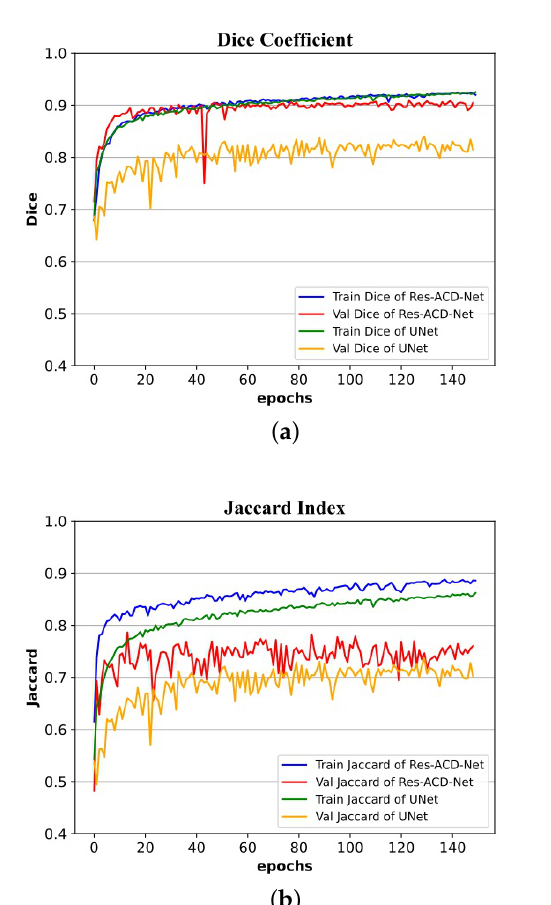
Figure 9. Training and validation processes on the ISIC-2017 dataset: ( a ) curves of Dice coefficient; ( b ) curves of Jaccard